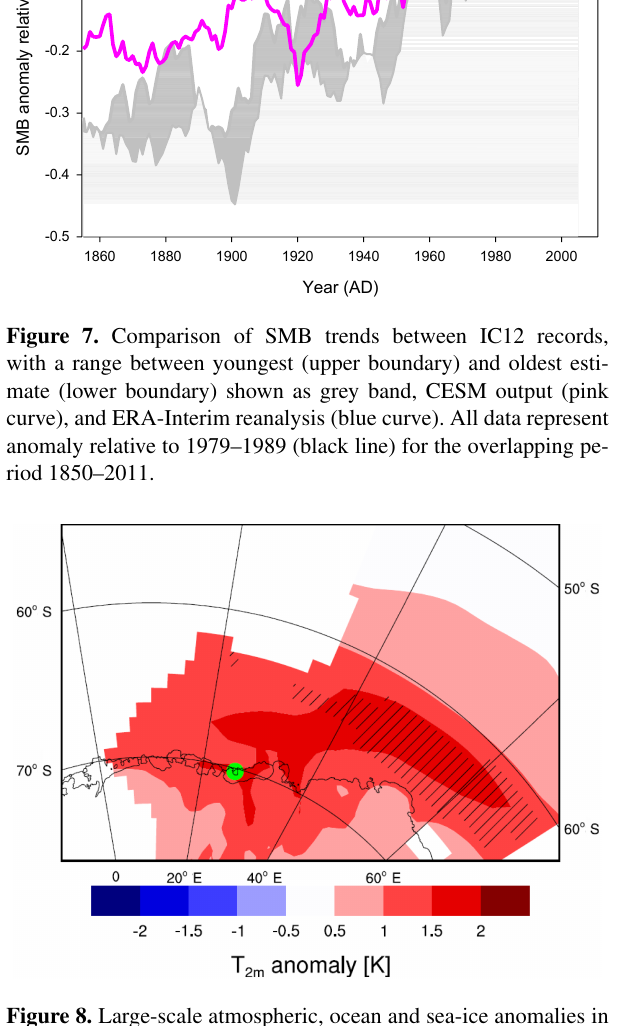
Figure 8. Large-scale atmospheric, ocean and sea-ice anomalies in high-SMB (10% highest) years in the CESM historical time series (1850–2005). The colours show the annual mean near-surface tem- perature anomaly (in ◦ C), and the hatched areas show the anomaly in sea-ice coverage (>20days less sea ice cover than the mean). The green dot shows the location of the ice